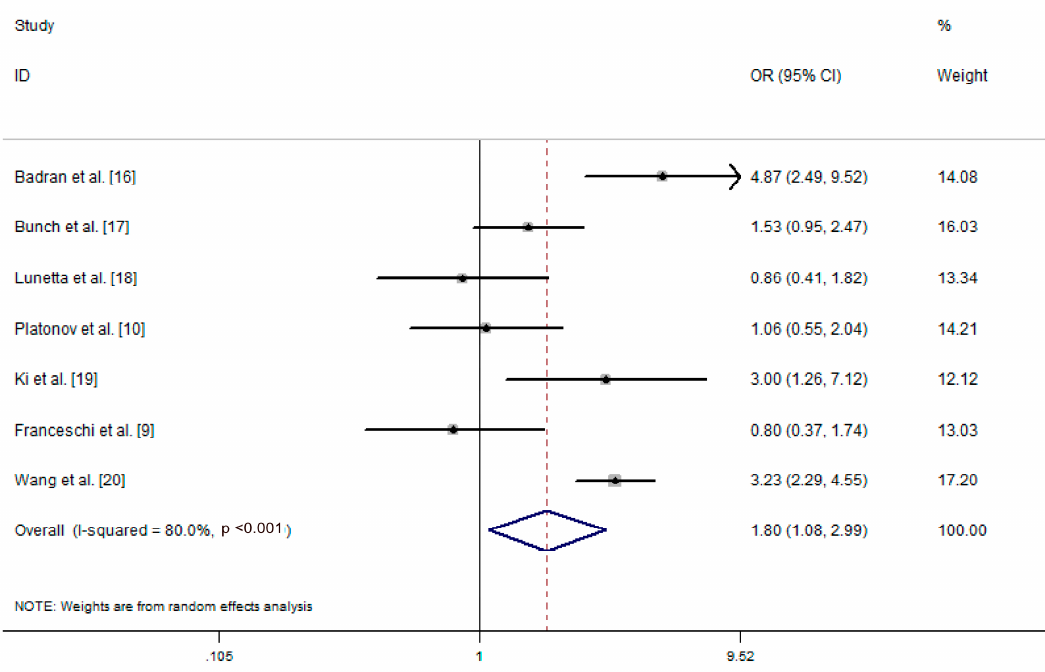
Figure 2. Effect estimates and pooled estimate of included studies reporting the association of arrhythmia and Helicobacter pylori infection. OR, odds ratio; CI, confidence interval.